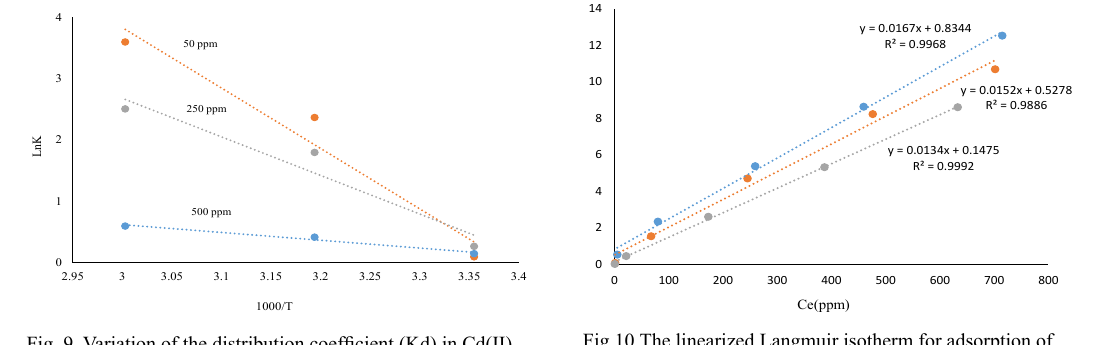
Fig 10.The linearized Langmuir isotherm for adsorption of Fig. 9. Variation of the distribution coefficient (Kd) in Cd(II) Cd(II) by natural ion removal using the natural zeolite as a function of temperature Table 4. Thermodynamic parameters for zeolite adsorption of cadmium ions. Table 4. Thermodynamic parameters for zeolite adsorption of cadmium ions.